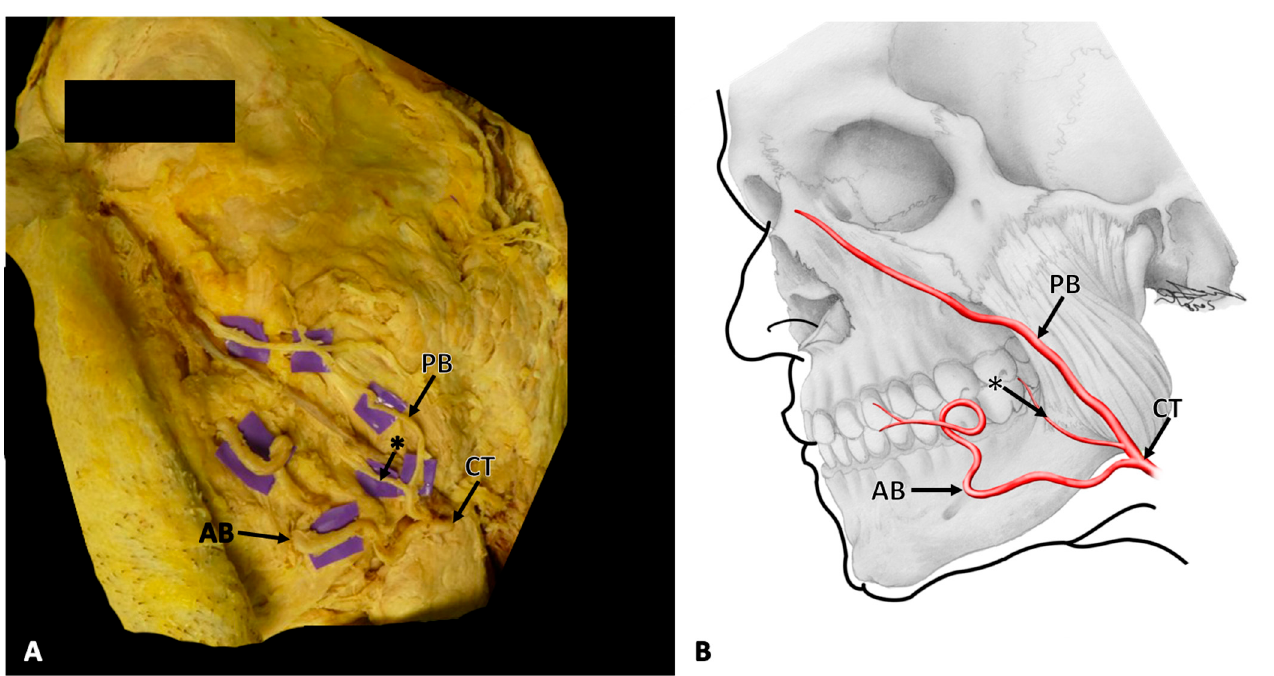
Figure 1. ( A ) The dissection situs of the left side of a male face with a rare variation in the branching pattern of the facial artery. ( B ) A schematic depiction of the dissection situs and branching pattern of the facial artery on the left side of the face in the same orientation. The common trunk (CT) of the facial artery splits at the level of the base of the mandible into an anterior branch (AB) and a posterior branch (PB) that gives off the premasseteric branch ( * ).